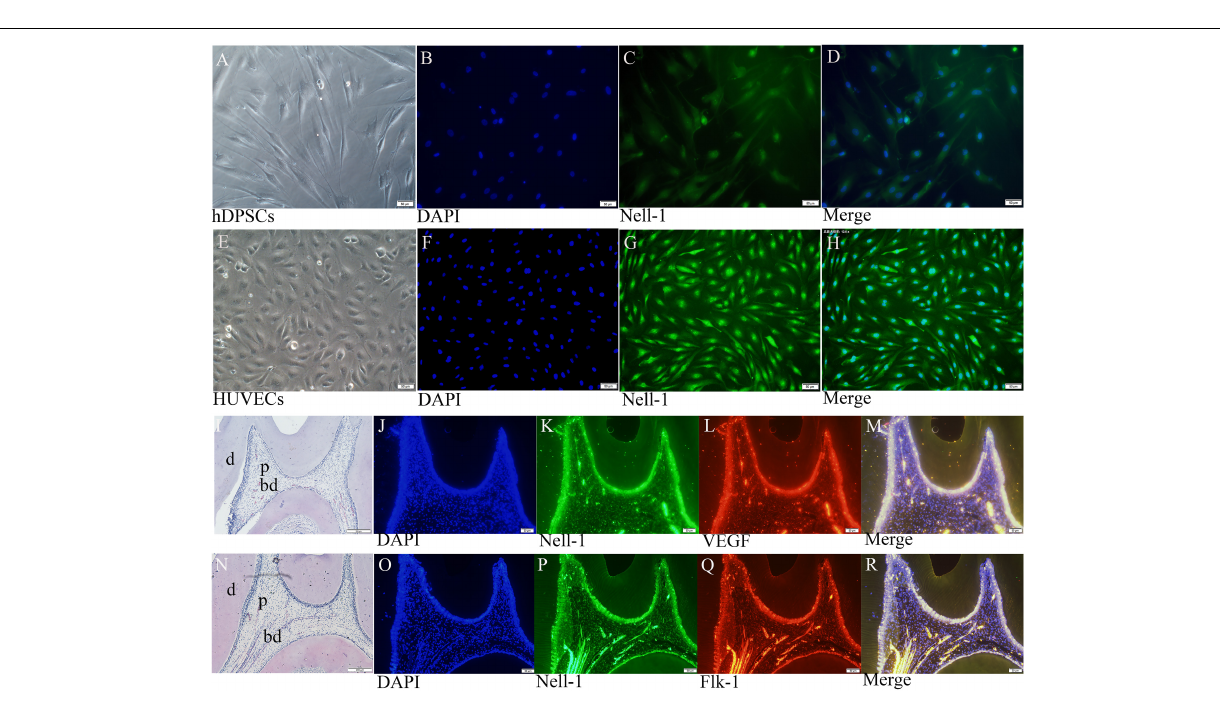
Frontiers in Physiology |